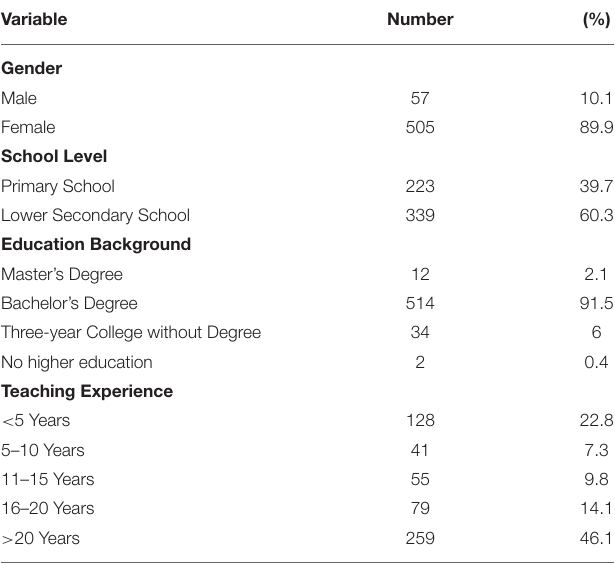
TABLE 1 | Demographic information of the participants ( N =